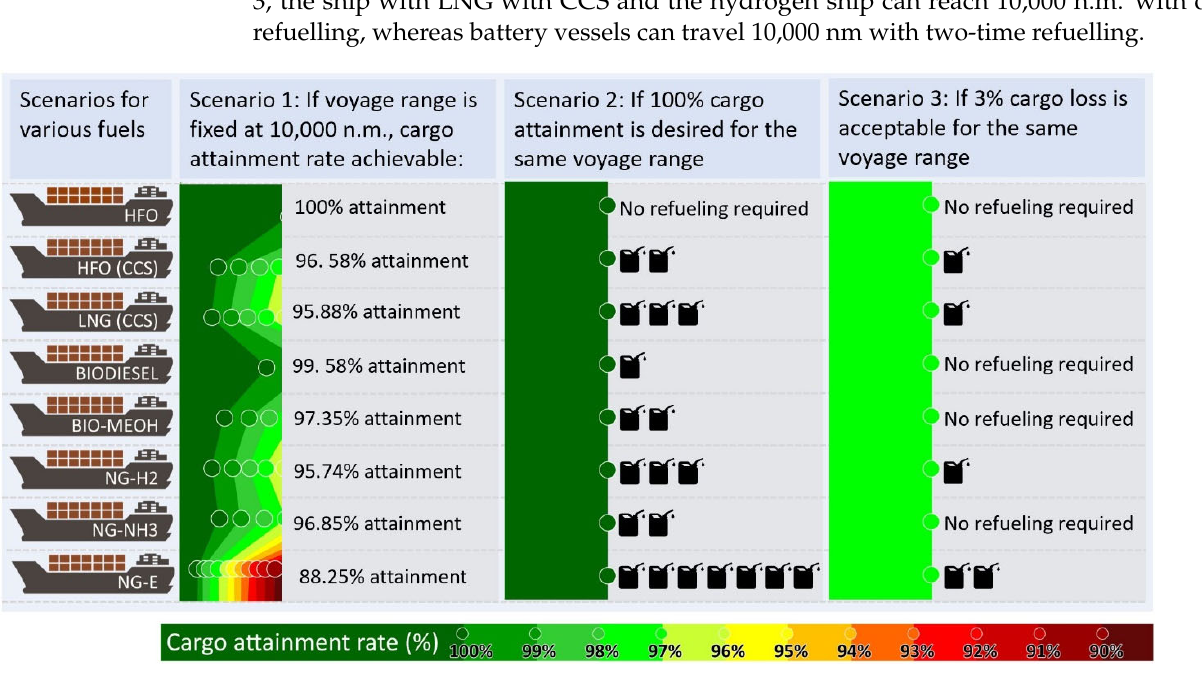
Figure 12. Scenarios ‐ based analysis for deep ‐ seagoing containership with voyage distance of 10,000 nm.